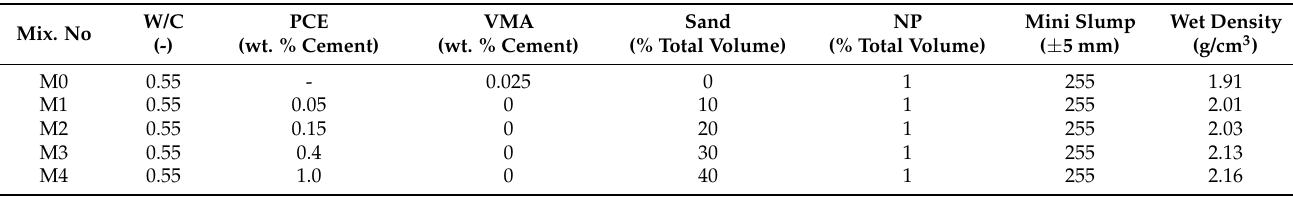
Figure 3. Schematic representation of mixture proportions. Table 3. Mixture proportions and fresh